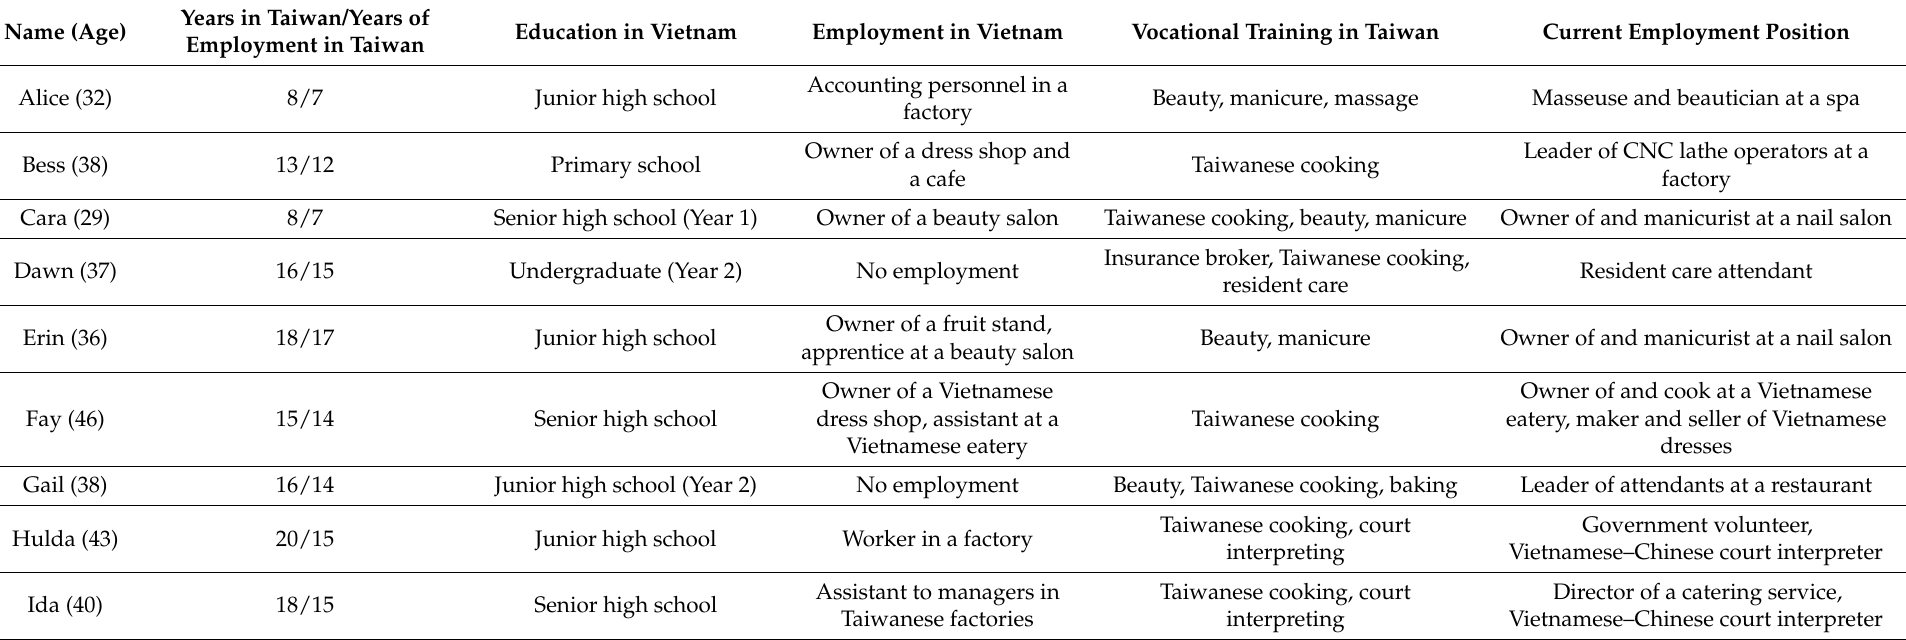
Table 1. The backgrounds of the